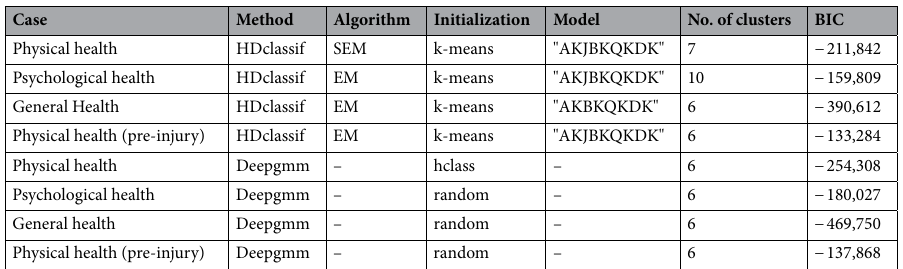
Table 1. Tuning parameters for HDclassif and Deepgmm, optimal number of clusters and BIC for the different set of variables (cases).